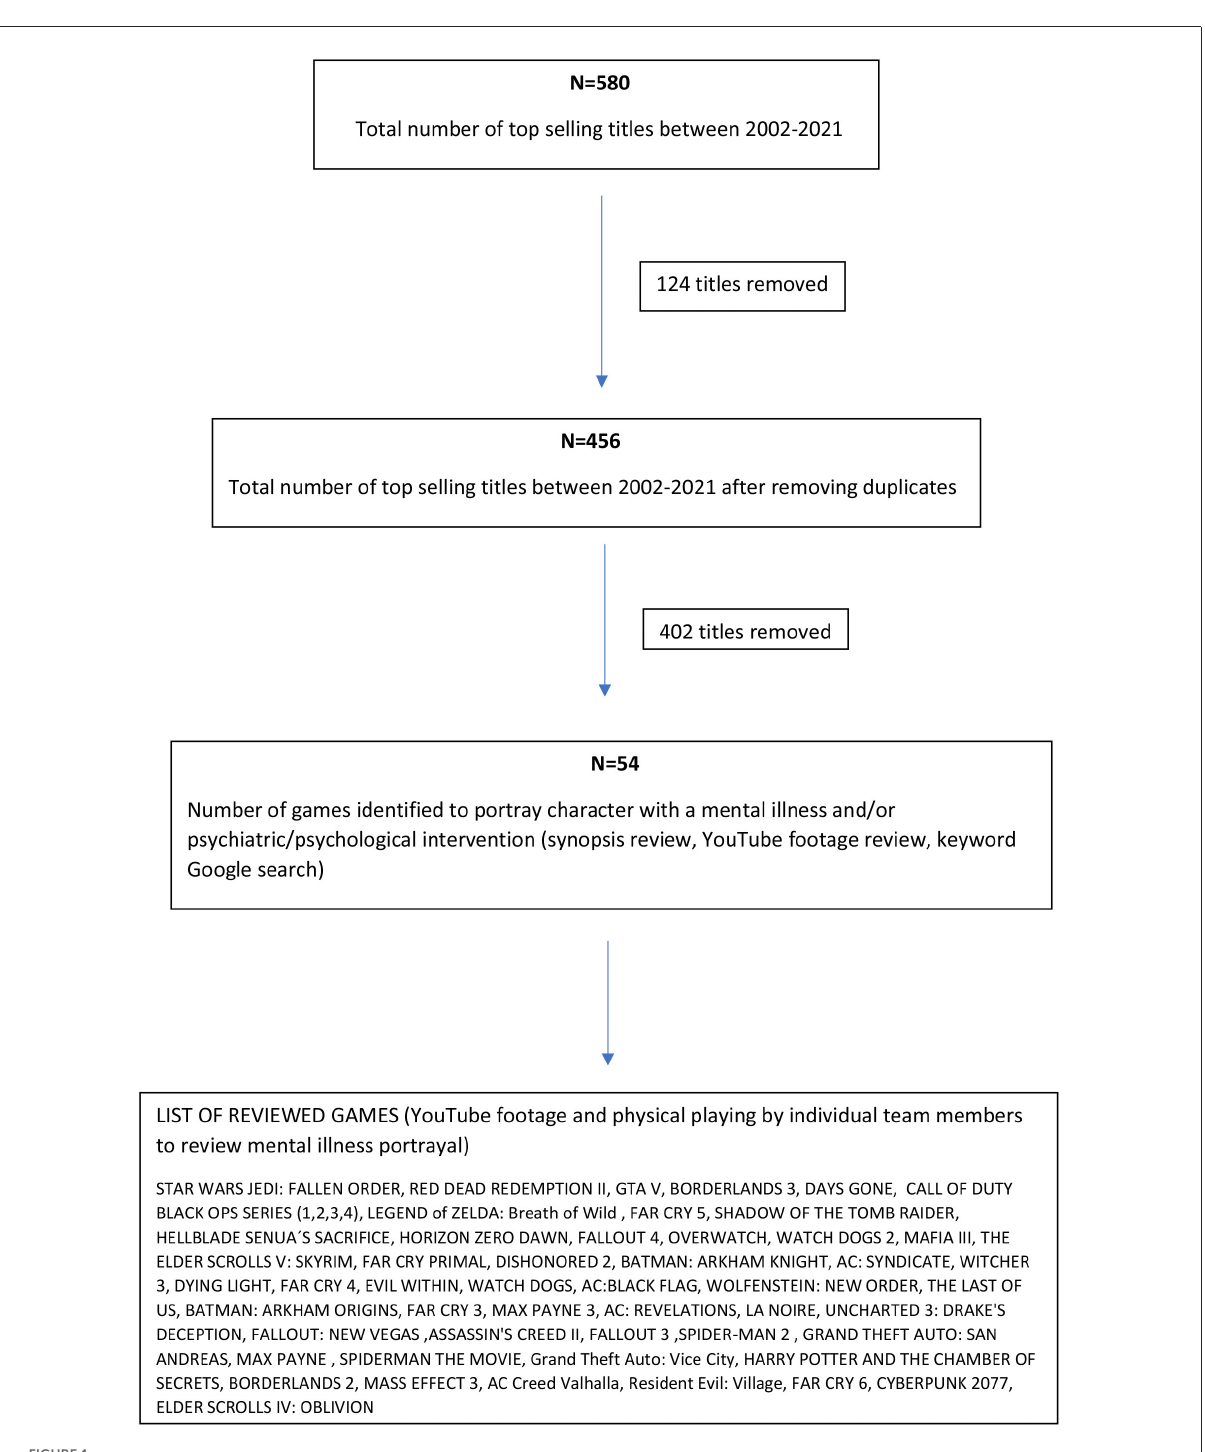
she is not manifesting any symptoms of depression)– these games were thus not included as a graphic presentation of a mental